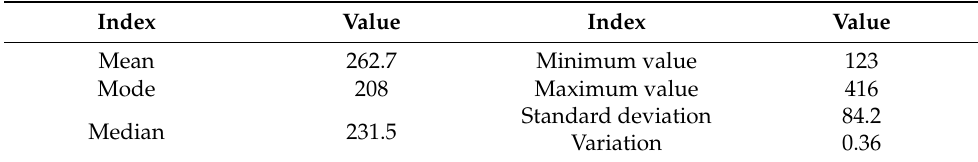
data heterogeneity, Table 2. Descriptive statistics for the LP variable.